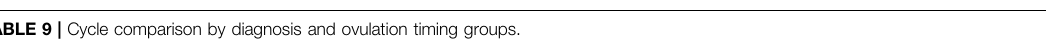
TABLE 9 | Cycle comparison by diagnosis and ovulation timing groups.